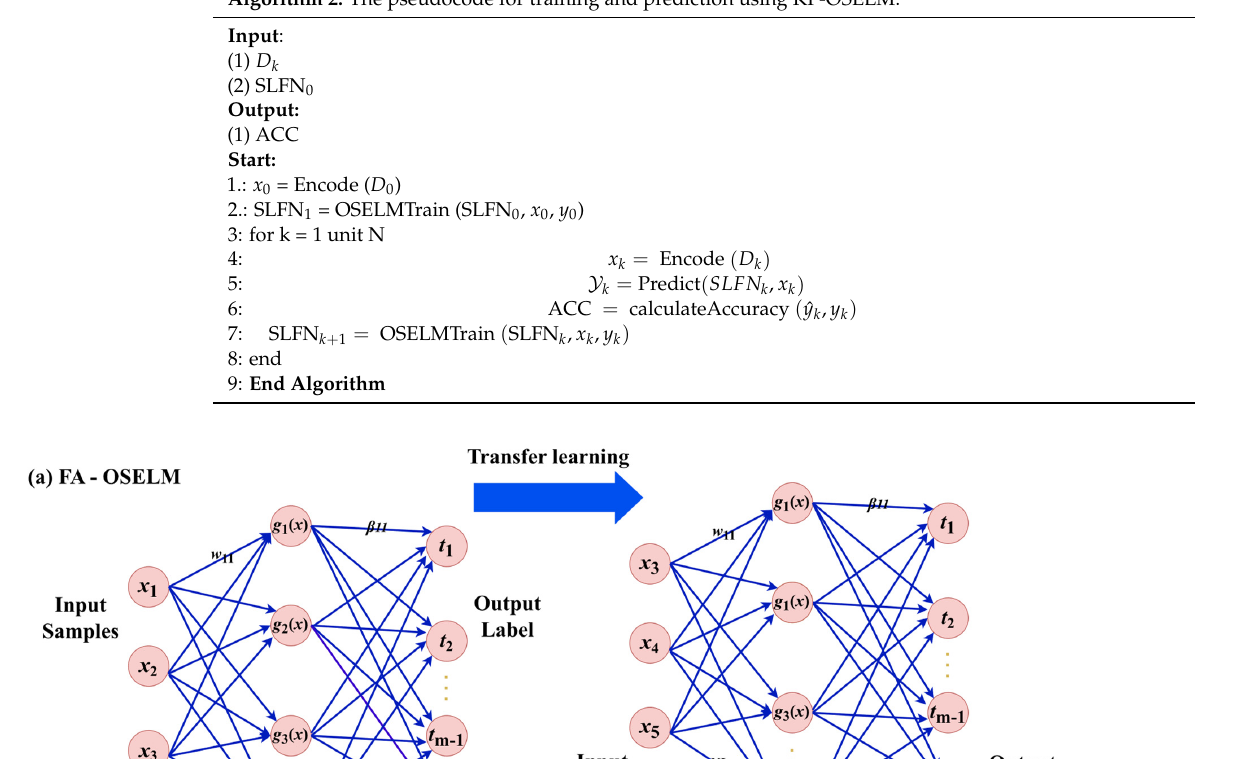
Algorithm 2. The pseudocode for training and prediction using KP-OSELM.